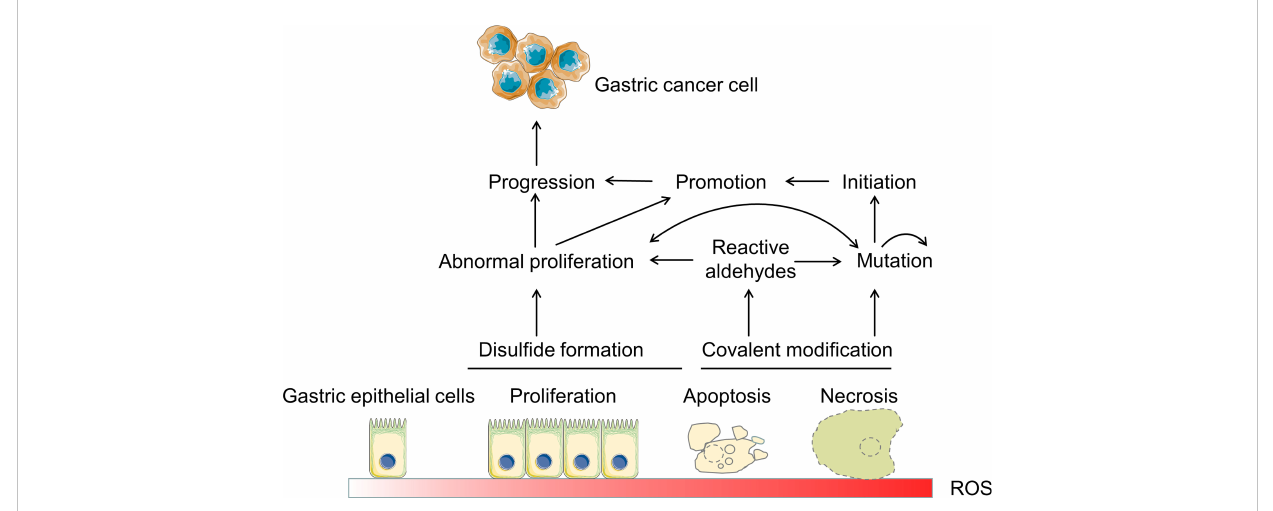
FIGURE 2 The Various pathways of ROS production and DNA damage by the epithelial and immune cells. CagA, cytotoxin-associated gene A; SMO, spermine oxidase; H 2 O 2 , hydrogen peroxide; VacA, vacuolating cytotoxin A; HO-1, heme oxygenase 1; ROS, reactive oxygen